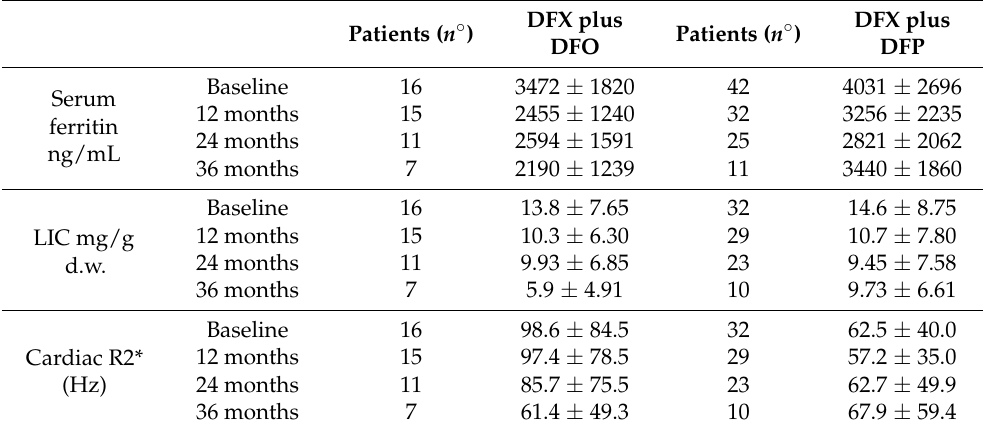
Table 1. Mean ± SD of serum ferritin, LIC, and cardiac R2* at different times for patients treated with DFX plus DFO and DFX plus DFP.